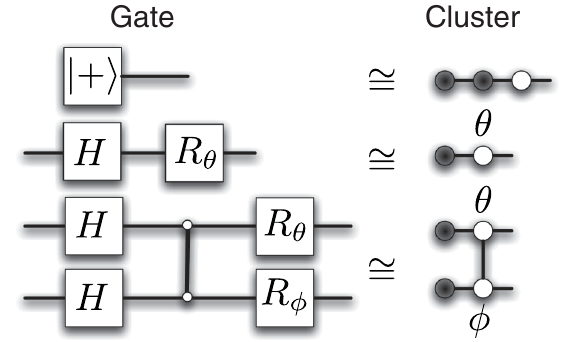
FIG. 4. Dictionary for translating a quantum circuit into the cluster-state Hamiltonian (see one-way QC [9]). First, express ¼ the quantum circuit in the universal gate set above, where R (cid:1) exp ð(cid:1) i(cid:1)Z= 2 Þ , H is a Hadamard gate, and the two-qubit gate is a controlled-phase gate, along with preparations of the þ 1 eigen- value of X , jþi . Then, convert this circuit into a graph and corresponding twisted cluster-state Hamiltonian by converting the circuit graph to a twisted cluster-state graph using the diagramed dictionary. For each of the unitary operators above, the corresponding gadget is labeled by its input (shaded) and output (unshaded) qubits. To construct the graph from the gate circuit, replace each unitary gate with the corresponding graph, merging output (unshaded) and input (shaded) qubits. For the nonunitary preparation of jþi , the inputs are never merged, but the output is merged with any input that this circuit element proceeds. The end result of this construction will be a labeled (by gates) graph corresponding to a twisted the angles in the R (cid:1) cluster-state Hamiltonian. Output qubits will not have been merged and will be in the location of the quantum information after the adiabatic procedure described in the text has been